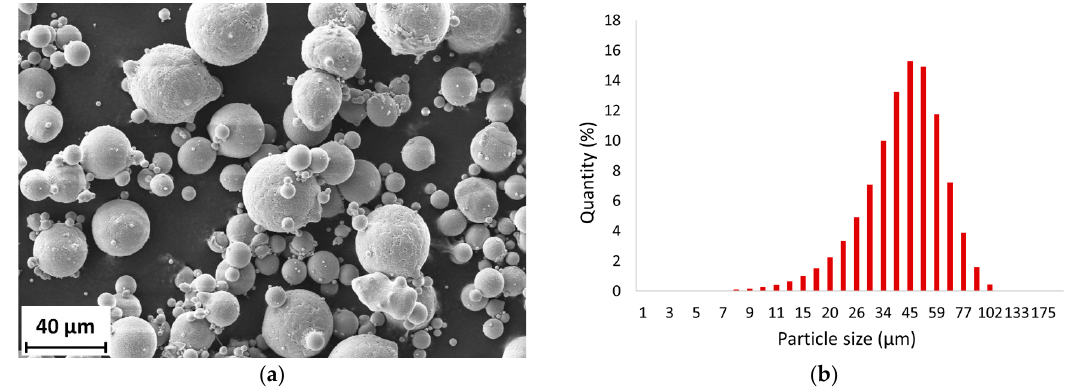
Figure 1. SLM powder characteristics; ( a ) particle shape (SEM); ( b ) particle size distribution chart.